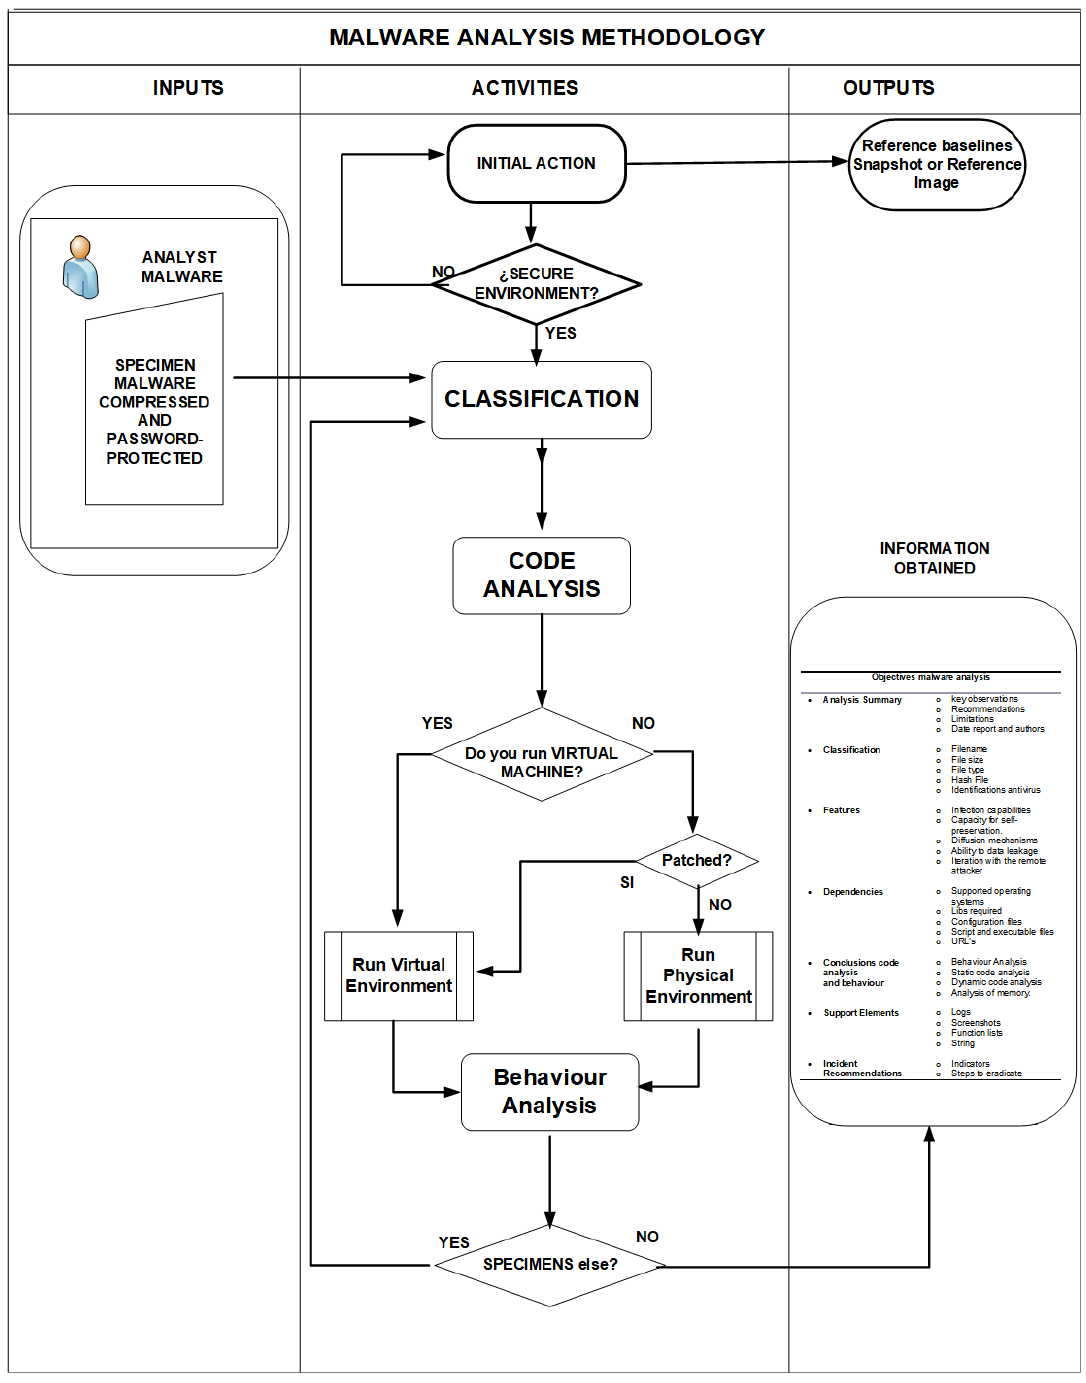
Figure 3. Diagram of the malware analysis methodology.